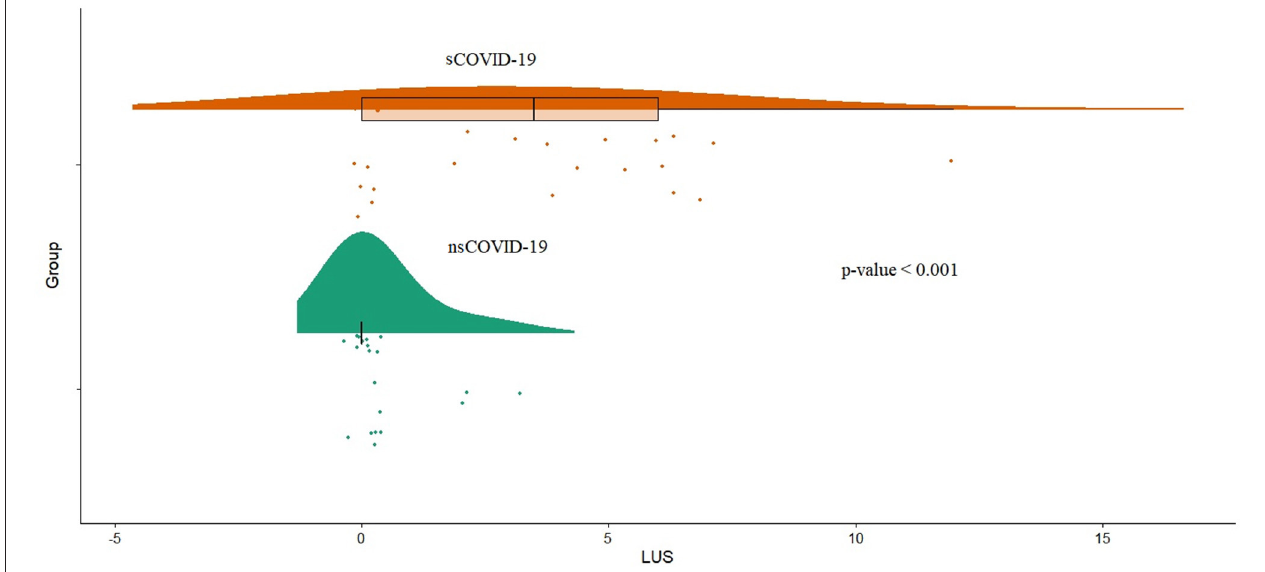
FIGURE 3 | Distribution of LUS score (LUS1) values between symptomatic COVID-19 patients group (sCOVID-19) and asymptomatic group (nsCOVID-19) ( p < 0.001). LUS, lung ultrasound.